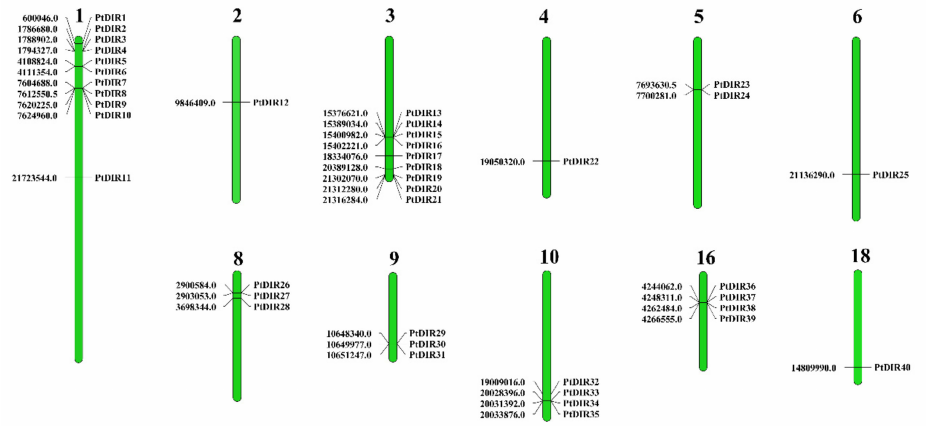
Figure 4. Chromosomal distribution of